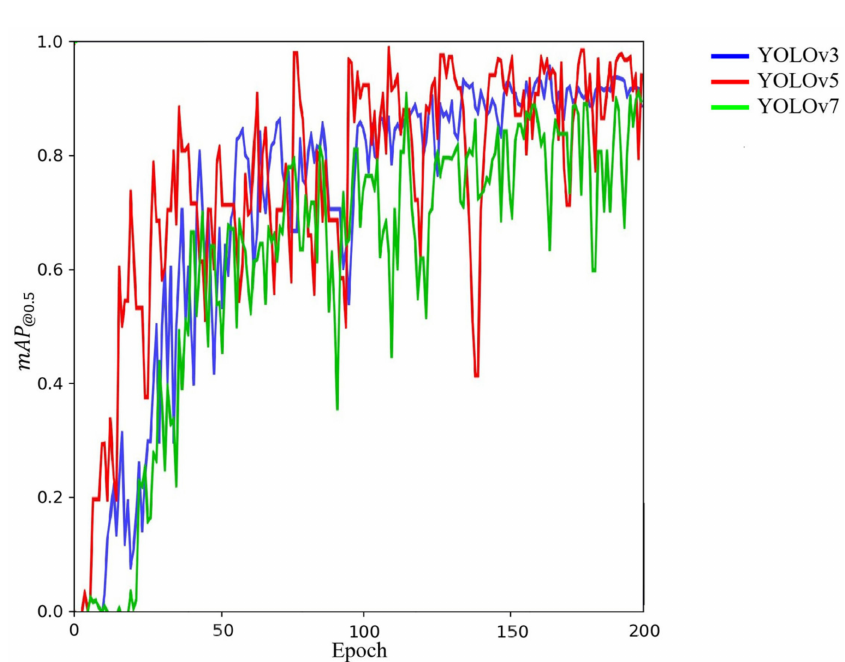
Figure 14. mAP @0.5